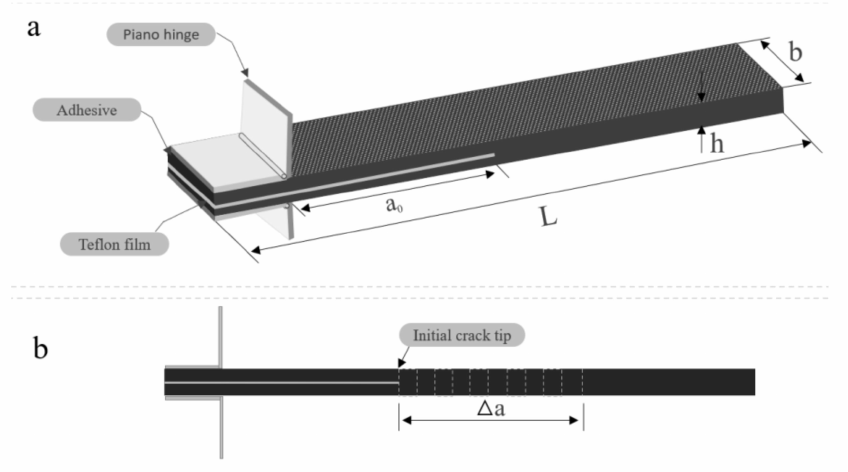
Figure 3. Schematic representation of the double cantilever beam (DCB) specimen: ( a ) with piano hinges; ( b ) initial crack